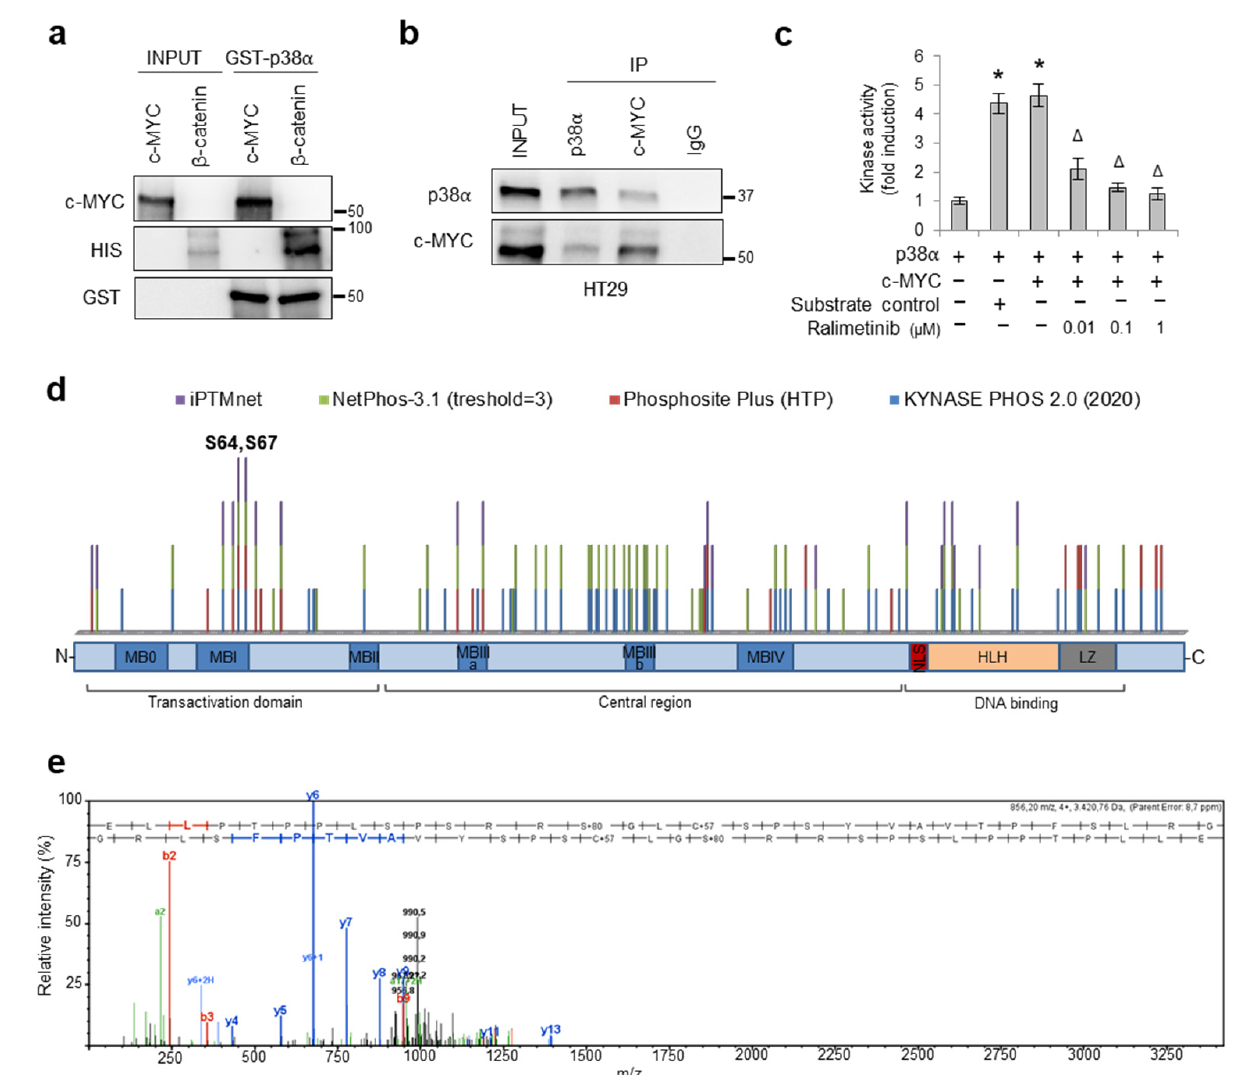
Figure 5. p38 α interacts with and phosphorylates c-MYC. ( a ) In vitro binding assay between GST-p38 α fusion protein and c-MYC recombinant protein. Bound proteins were analyzed by im- munoblotting using anti-GST, anti-HIS, and anti-c-MYC antibodies. HIS- β -catenin was used as a positive control. ( b ) Co-immunoprecipitation of endogenous p38 α and c-MYC in HT29 cells. ( c ) In vitro kinase assay showing c-MYC phosphorylation by p38 α in the absence or presence of ralimetinib at the indicated concentrations. Statistical analysis was performed using Student’s t -test, * p < 0.05 vs. active p38 α ; ∆ p < 0.05 vs. active p38 α + c-MYC. ( d ) In silico phosphorylation prediction meta-analysis. Four in silico prediction servers were used to identify MYC consensus phospho- rylation sites: iPTMnet (https://research.bioinformatics.udel.edu/iptmnet; accessed on 14 April